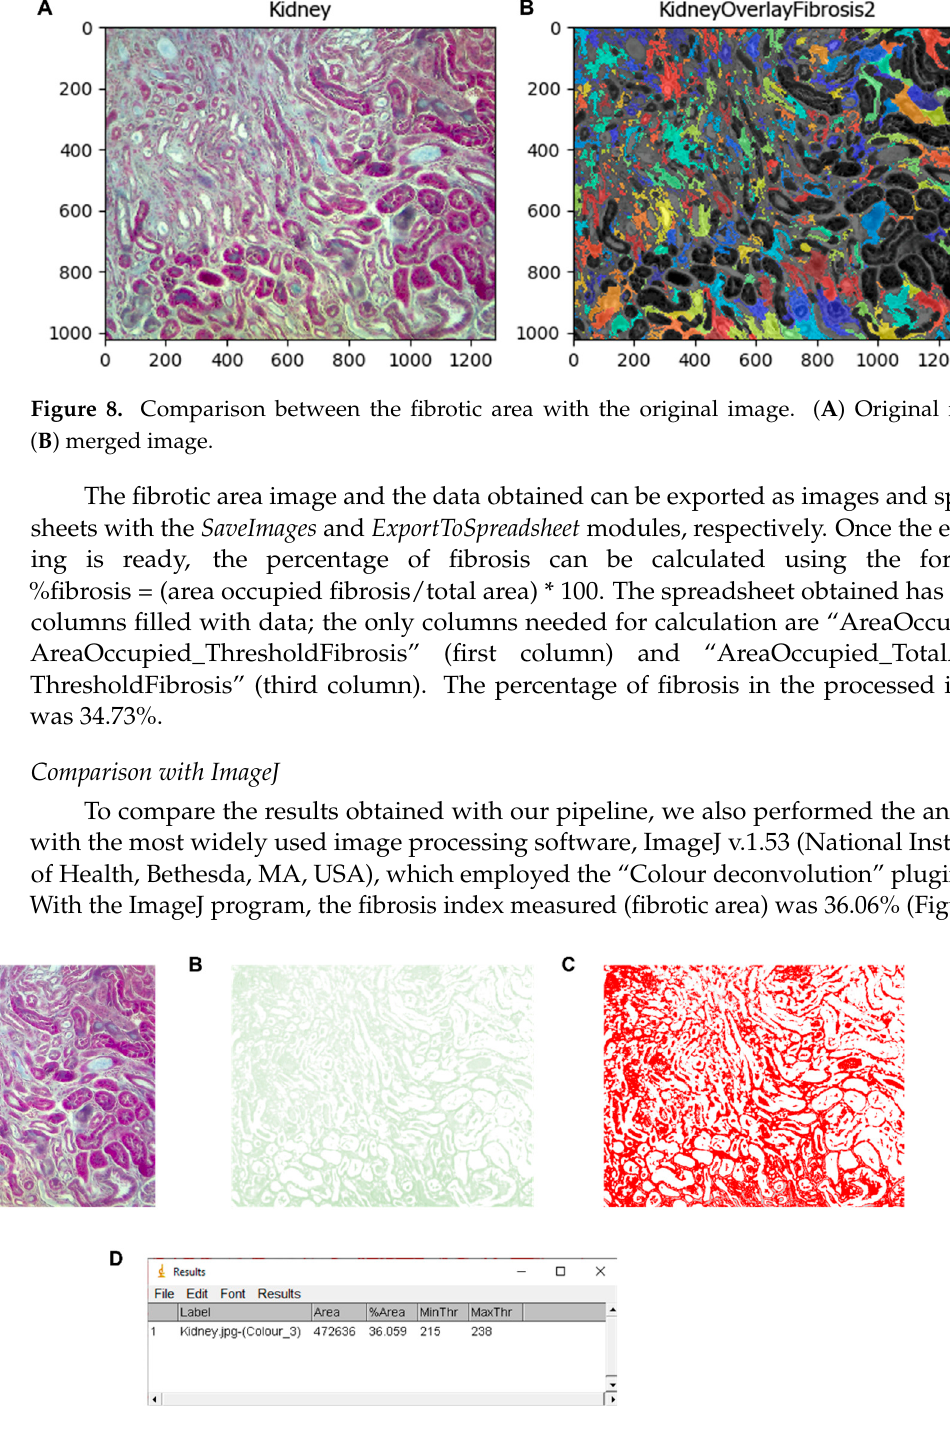
Figure 9. Fibrotic area calculation using ImageJ. ( A ) Original image, ( B ) green channel, ( C ) thresholded, and ( D ) measured fibrosis area and percentage with the minimum and maximum threshold values.